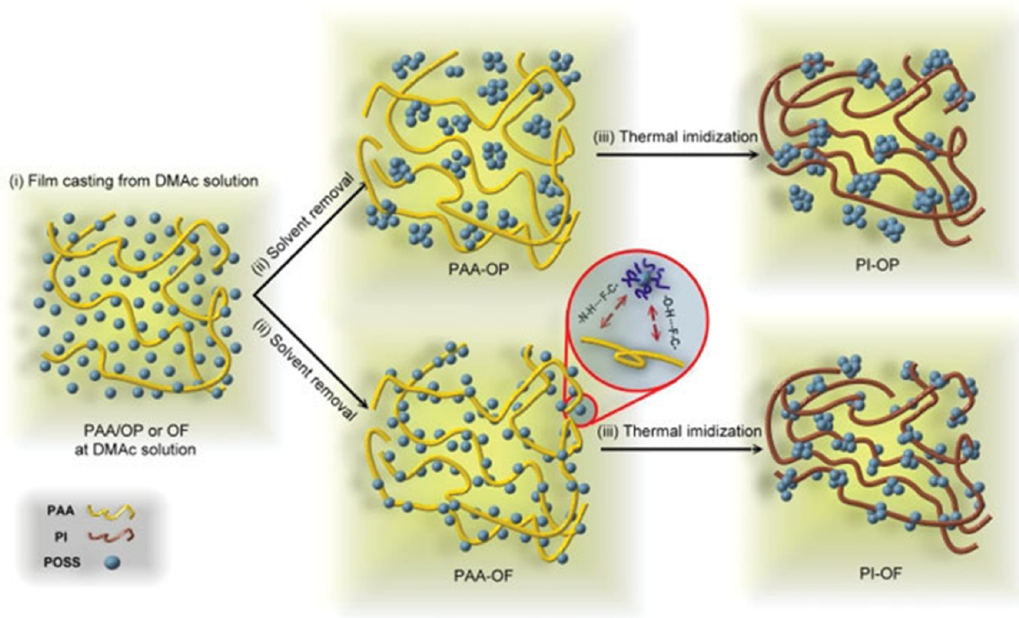
Figure 2. Cartoon representation of the deformation processes of Polyimide (PI)/octakis(dimethylsiloxyhexafluoropropyl) silsesquioxane (OF)-POSS and (OP)-POSS NPs during imidization [71]. Reproduced with permission from Wiley.